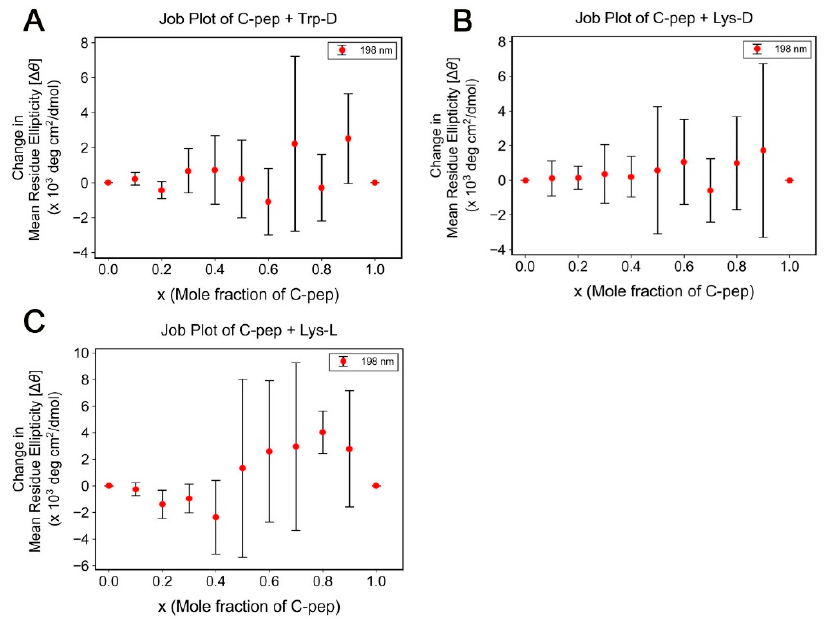
Figure 10. Job plots of C-peptide and ( A ) Trp-D, ( B ) Lys-D, and ( C ) Lys-L at a total concentration of 1 mM as determined at 198 nm. The standard deviations are derived from three separate measurements over the course of two weeks. The absence of a well-defined peak in the plots suggests that the co-assembly of C-peptide and the 9mer com-peptides is not optimized yet.